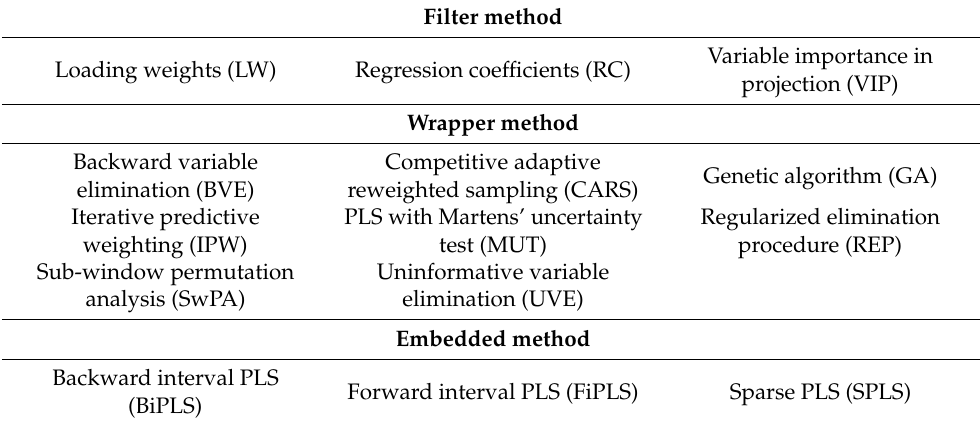
Table 1. Variable selection methods used in this